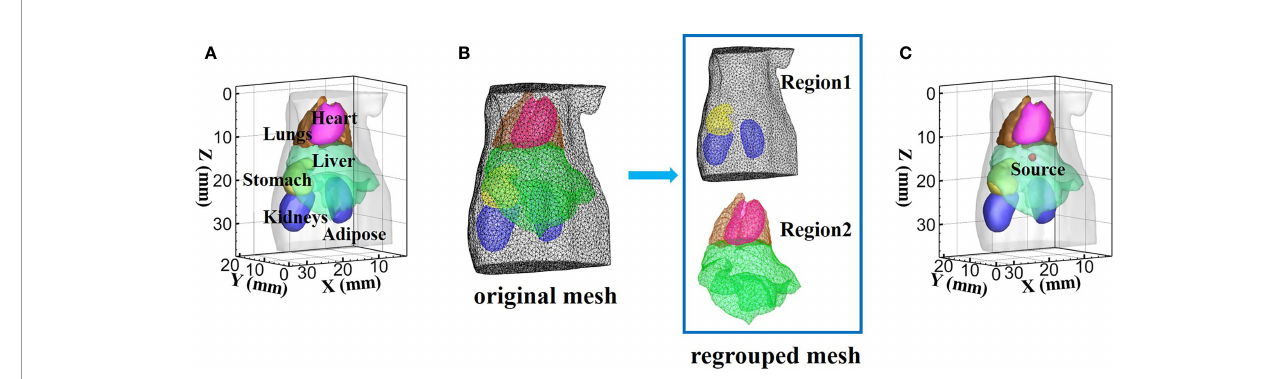
FIGURE 4 | The digital mouse used in the simulation experiment. (A) The mouse model with six organs. (B) Display of mesh regrouping in a mouse model. (C) Model of source in the liver.